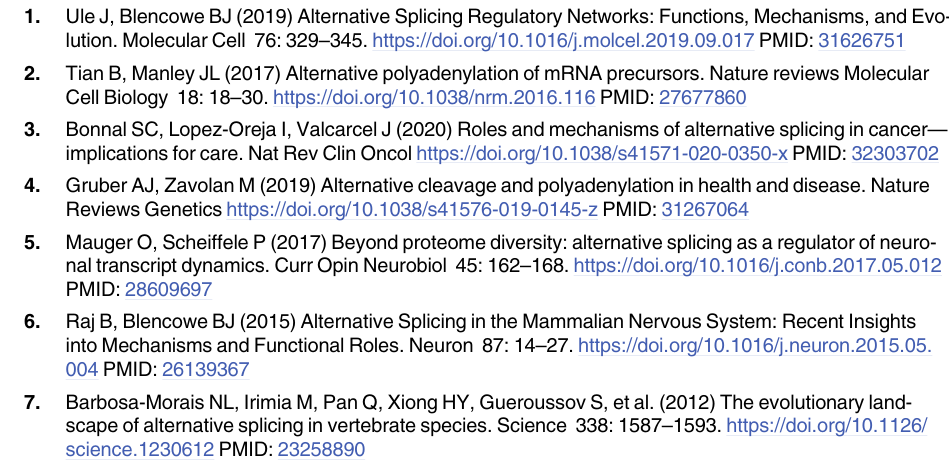
S4 Table. Human genes with neuronal-specific alteration of alternative last exon and ter- minal 3’ UTR isoforms, as determined from in vitro differentiation of iPSCs into neurons. S5 Table. Oligonucleotides used in this study to analyze regulated mRNA isoforms, geno- type mutants, and prepare CLIP